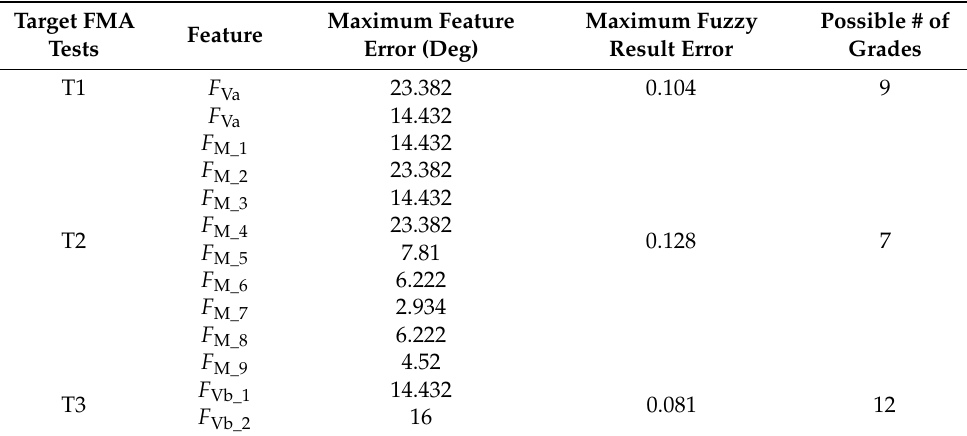
Table 6. Estimated fuzzy result error and possible number of grades for each FMA